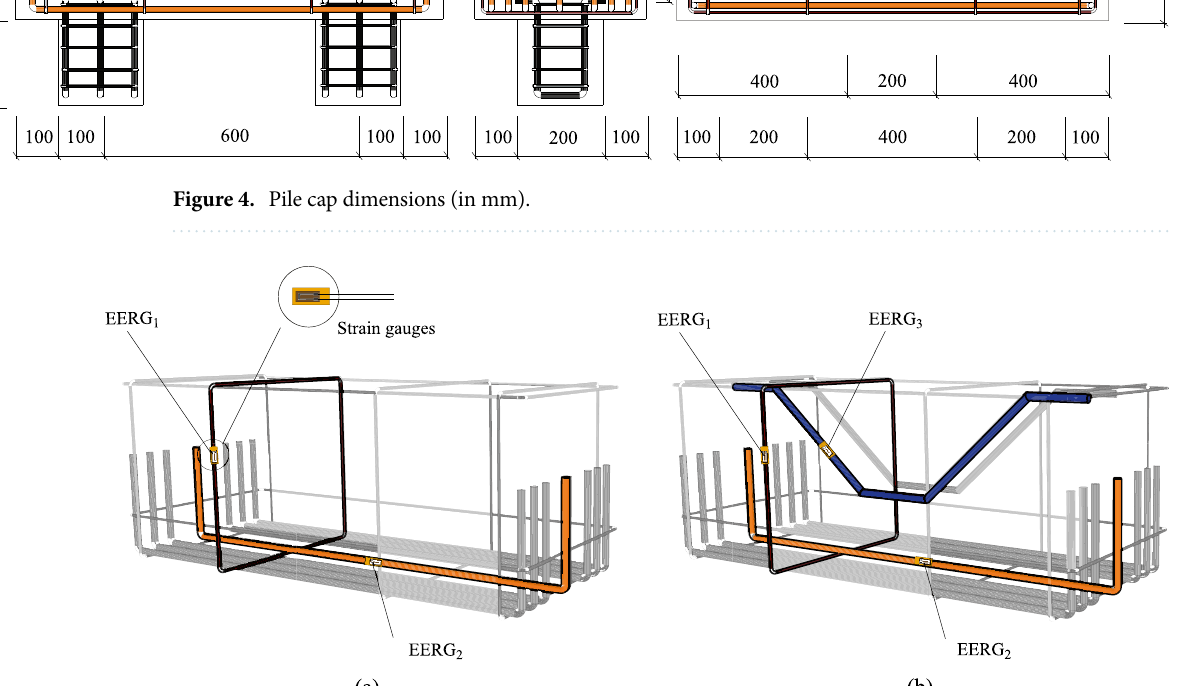
Figure 5. Position of strain gauges on the reinforcements: ( a ) for PC01 REF and PC04 IR and ( b ) for PC02 SFRC and PC03